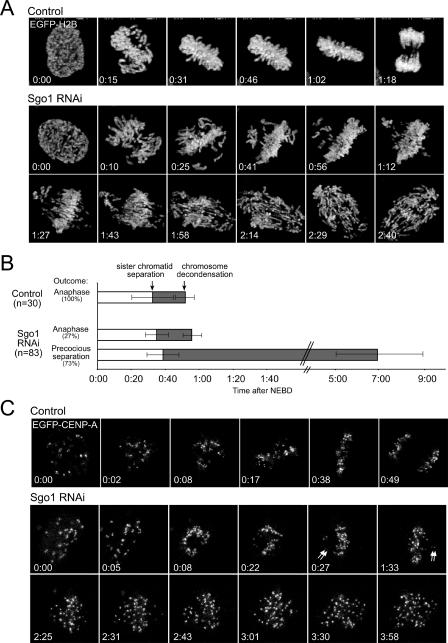
Live Cell Analysis of Sgo1-Depleted Cells(A) Synchronised HeLa cells expressing EGFP-tagged histone H2B were transfected with Sgo1 siRNA or dH2O as in Figure 1A, and analysed with time-lapse confocal microscopy. Stacks of 12 different z-plane images were obtained every 5 min and projected images for several time points are shown. Note that several chromosomes failed to congress to the metaphase plate, which was followed by progressive sister chromatid separation over time. Typically, a pair of disjoining sister chromatids dissociated simultaneously from the metaphase plate towards opposite poles.(B) Summary of live cell analysis. Cells prepared as in (A) were examined by time-lapse immunofluorescence microscopy. Mitotic cells were aligned on the time axis according to NEBD as determined from the loss of a defined nuclear boundary. Time from NEBD to anaphase onset/sister chromatid separation (white portion of bars) and from this point to chromosome decondensation or apoptosis (grey portion of bars) was measured.(C) To follow centromere dynamics, cells expressing EGFP-CENP-A were either mock-treated or Sgo1 siRNA transfected. Images were obtained by time-lapse confocal microscopy. Note that in cells depleted of Sgo1, dots of paired GFP-CENP-A can be found in earlier unaligned chromosomes (arrows). Single dots progressively fell apart in later phases, resulting in collapse of metaphase plate (images in lower row).